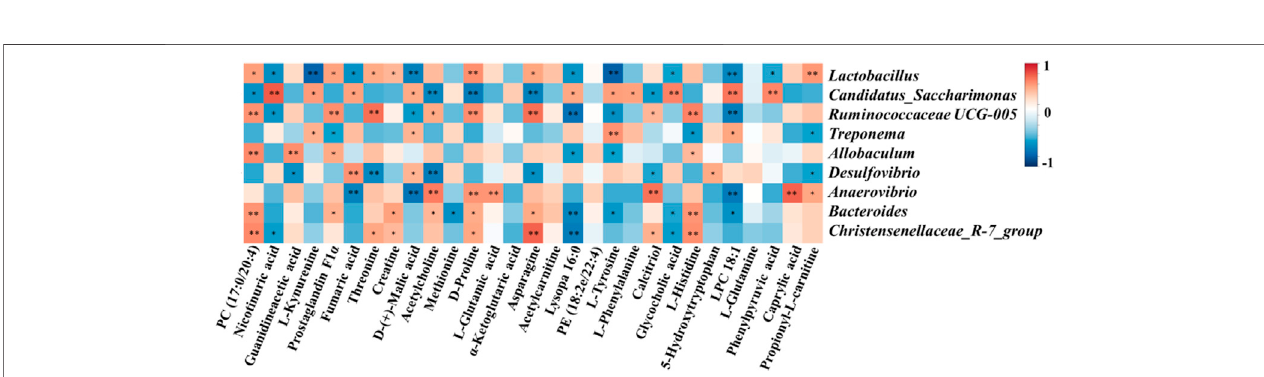
FIGURE 6 | Correlation analysis of untargeted metabolomics and 16S rRNA sequencing. Correlations between between untargeted metabolomics and gut microbiota were analyzed using spearman ’ s analysis (heatmap). X -axis represents the differential metabolites in the serum. Y -axis represents the gut microbiota with differential abundance. The colors of grids represent the correlation analysis value of spearman ’ s correlation analysis. Grids in red indicate positive correlations (correlation analysis value more than 0.1), while grids in blue indicate negative correlations (correlation analysis value less than − 0.1). Color coding scale indicates the correlation analysis value from heatmap, the deeper red or blue indicates higher correlation values. *: p < 0.05 between differential serum metabolites and gut microbiota. **: p < 0.01 between differential serum metabolites and gut microbiota.